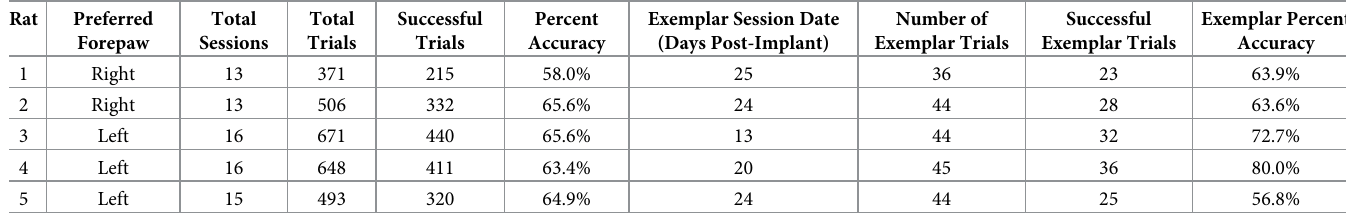
Table 1. Summary of task